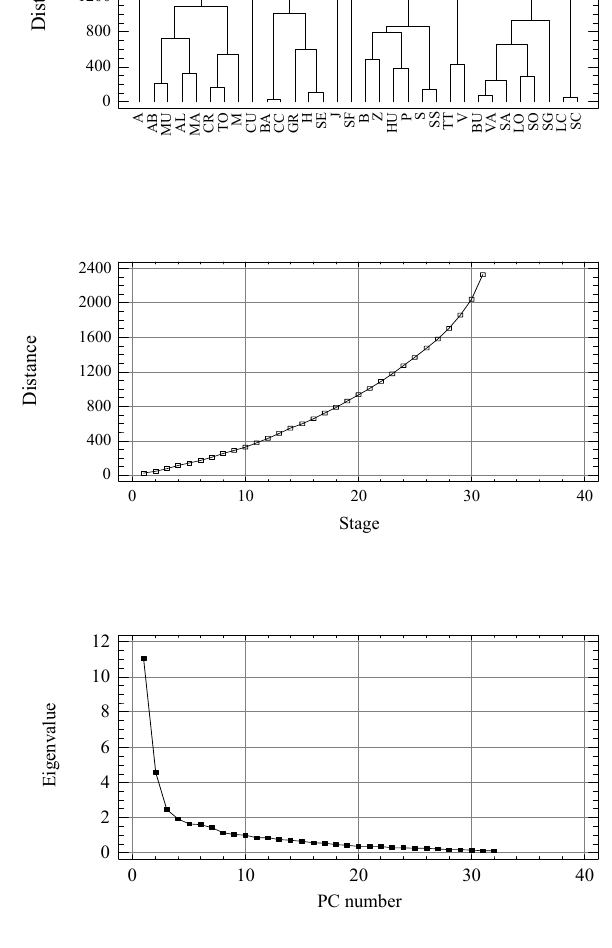
until stage 29 or 30, when the distances between combined clusters begin to become noticeably larger. A reasonable in- terpretation of this change in slope is that true clusters have been defined at this point, and that larger distances at later stages indicate mergers of clusters that should be distinct. A plausible point at which to stop the analysis would be after stage 29. This stopping point results in the definition of three clusters on the dendogram. Cluster 1 includes 68.7% of the observations, cluster 2 21.9% and cluster 3 9.4%. Figure 2 (bottom) shows eigenvalues as a function of the EOF number. In this case, three factors have been extracted, the third one accounting for more than 5% of the variance (Table 2). The first three EOFs account for the 68.87% of the total variance. Similar analysis can be seen in Figs. 3 to 5, corresponding to the other seasons of the year. Table 2 shows the percentage of explained variance corresponding to the first four unro- tated EOFs. If the criterium of accounting for more than 5% of the variance is accepted, results indicate that the